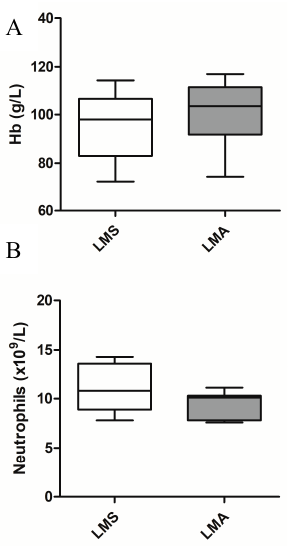
Figure 1. Box and whisker plots representing low haemoglobin (Hb) and neutrophilia between leiomyoma (LMA) and leiomyosarcoma (LMS) groups. ( A ) Hb results for LMS and LMA groups. LMS: Median = 98, 25% = 83, 75% = 106.5, Min = 72, Max = 114, ( n = 17). LMA: Median = 103.5, 25% = 91.8, 75% = 111.3, Min = 74, Max = 117, ( n = 28); ( B ) Neutrophil counts for LMS and LMA groups. LMS: Median = 10.8, 25% = 8.9, 75% = 13.6, Min = 7.8, Max = 14.3, ( n = 10). LMA: Median = 10.1, 25% = 7.8, 75% = 10.3, Min = 7.6, Max = 11.1, ( n = 9). Hb—haemoglobin, LMS—leiomyosarcoma, LMA— leiomyoma.